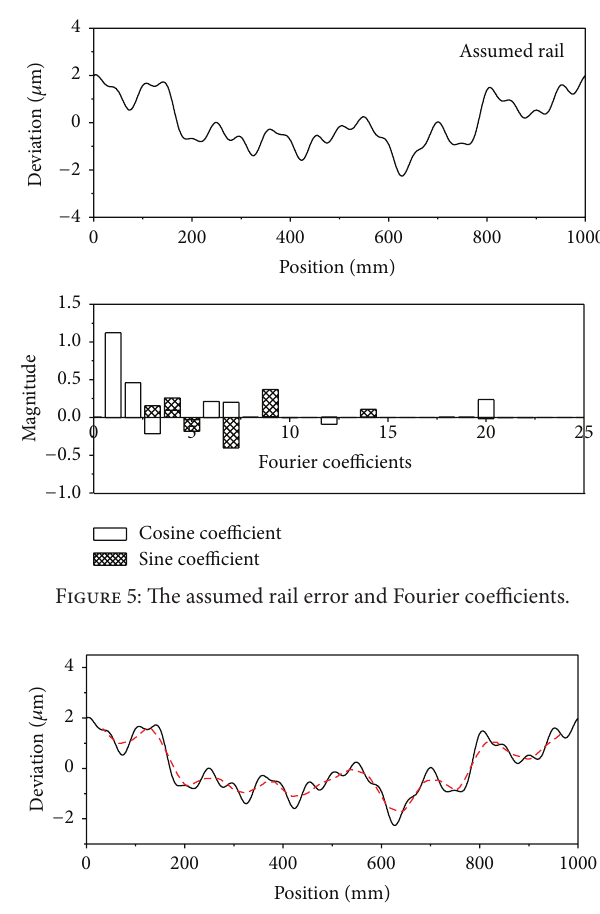
Figure 6: A comparison of the rail-form error and the calculated vertical straightness